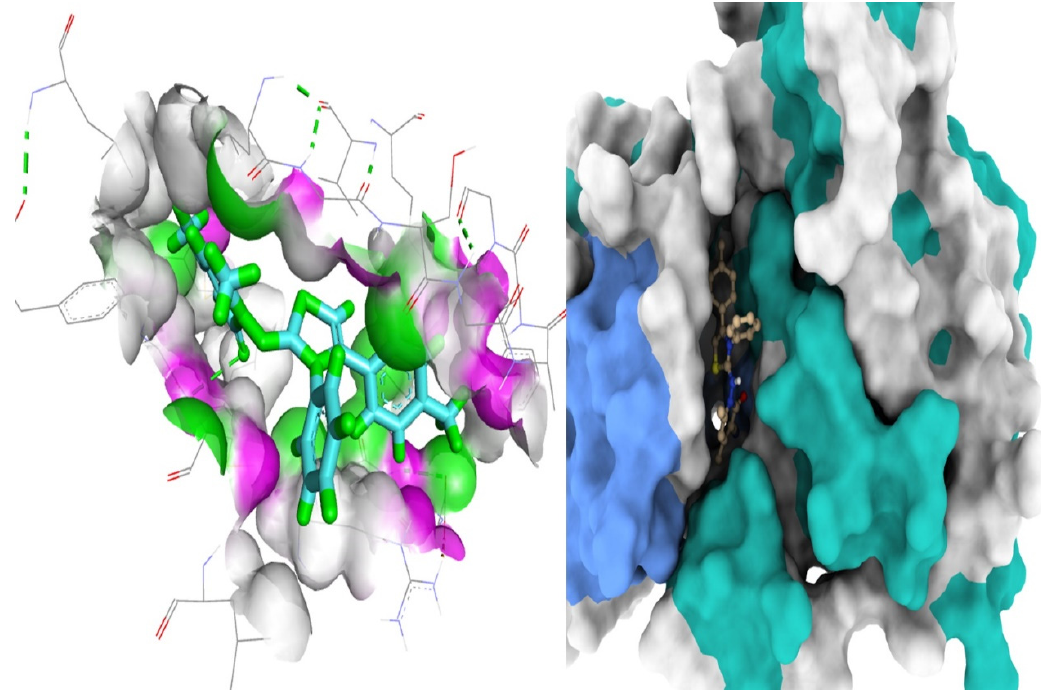
Figure 13. Mapping surface showing compound 6b occupying the active pocket of EGFR TK.